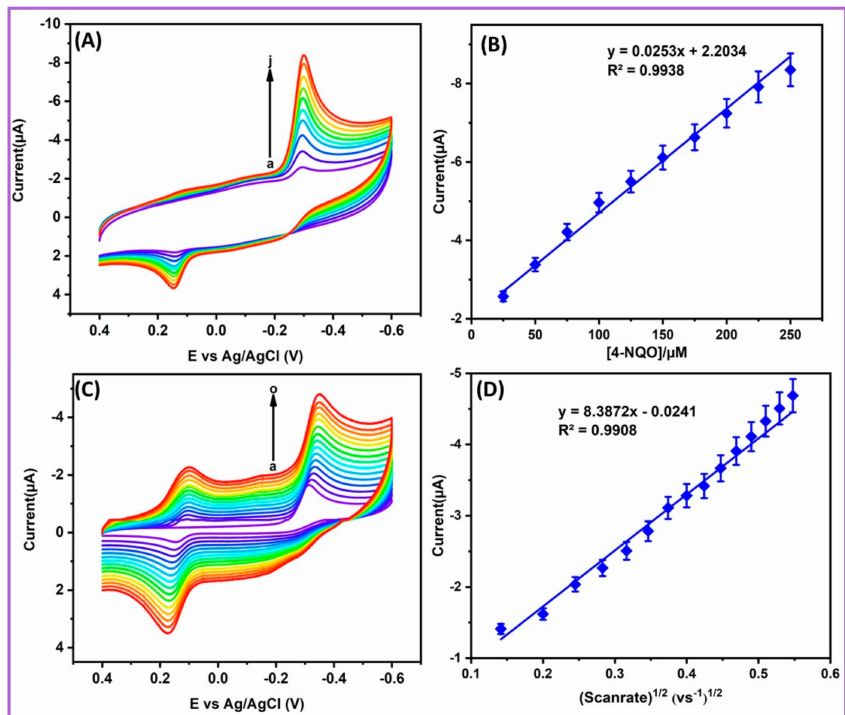
Figure 7. ( A ) CVs obtained at di ff erent concentration of 4-NQO ( a – j 25–250 µ M) and ( B ) Linear relationship between the current ( µ A) and 4-NQO concentration. ( C ) CVs attained for the di ff erent scan rate ( a – o 20 to 300 mVs − 1 ) in 0.1-M pH 7 at NiCo 2 S 4 -Ms / GCE. ( D ) Calibration plot of the cathodic peak current and scan